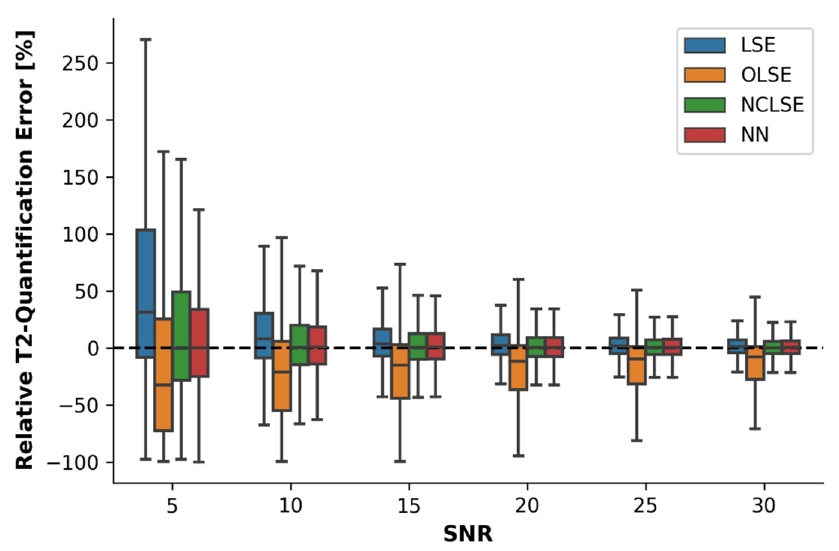
Figure 1. Relative quantification errors (RQEs) in the quantification of T2 relaxation times [%] as a function of the fitting method, i.e., the traditional Least-Squares Estimation (LSE) without any further modification, Offset LSE (OLSE), Noise-Corrected LSE (NCLSE), and the neural network (NN), and as a function of the signal-to-noise ratio (SNR). In silico modeling was done on a synthetic dataset consisting of 67 million training samples. Boxes represent the interquartile ranges (IQRs, defined as the difference between 25th and 75th percentiles) and horizontal lines represent the medians. Whiskers indicate the most extreme data points that are within the range of 1.5 × IQR from the edge of the box.